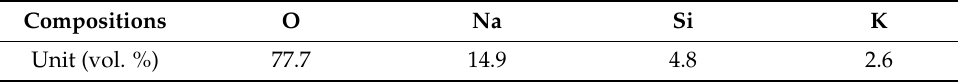
Table 2. Chemical composition of the admixture.